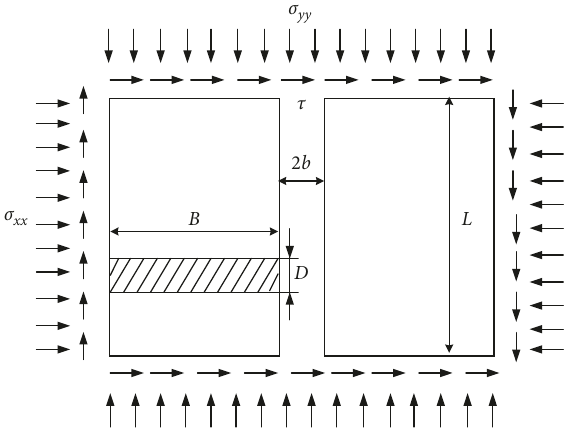
Figure 1: Mechanical model of surrounding rock failure